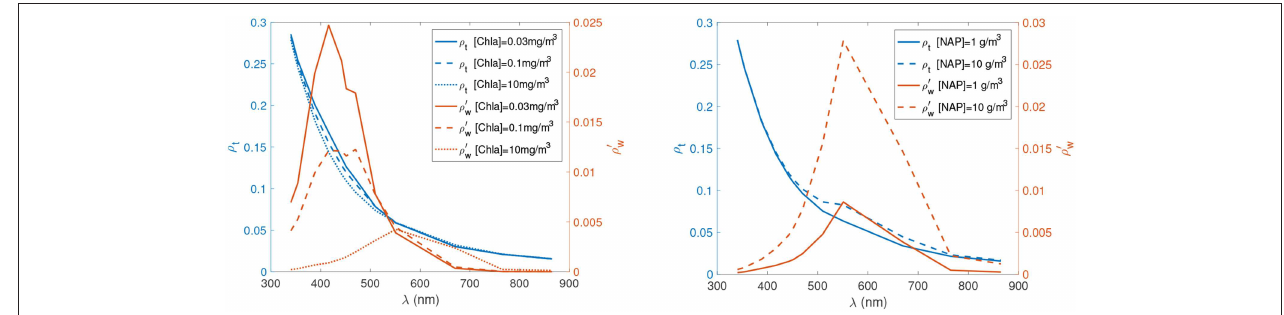
FIGURE 4 | TOA Reflectance at nadir as a function of wavelength. The total reflectance is shown in blue by the left y axis and the water leaving signal is shown in maroon by the right y axis. The differences between heavy, solid and dashed lines are due to differences in chlorophyll amounts (left) or non-algal particle concentrations (right) . The solar zenith angle is 45 degrees and the aerosol optical depth at 550nm is 0.15. Reprinted with permission from Zhai et al. (2017a), The Optical Society